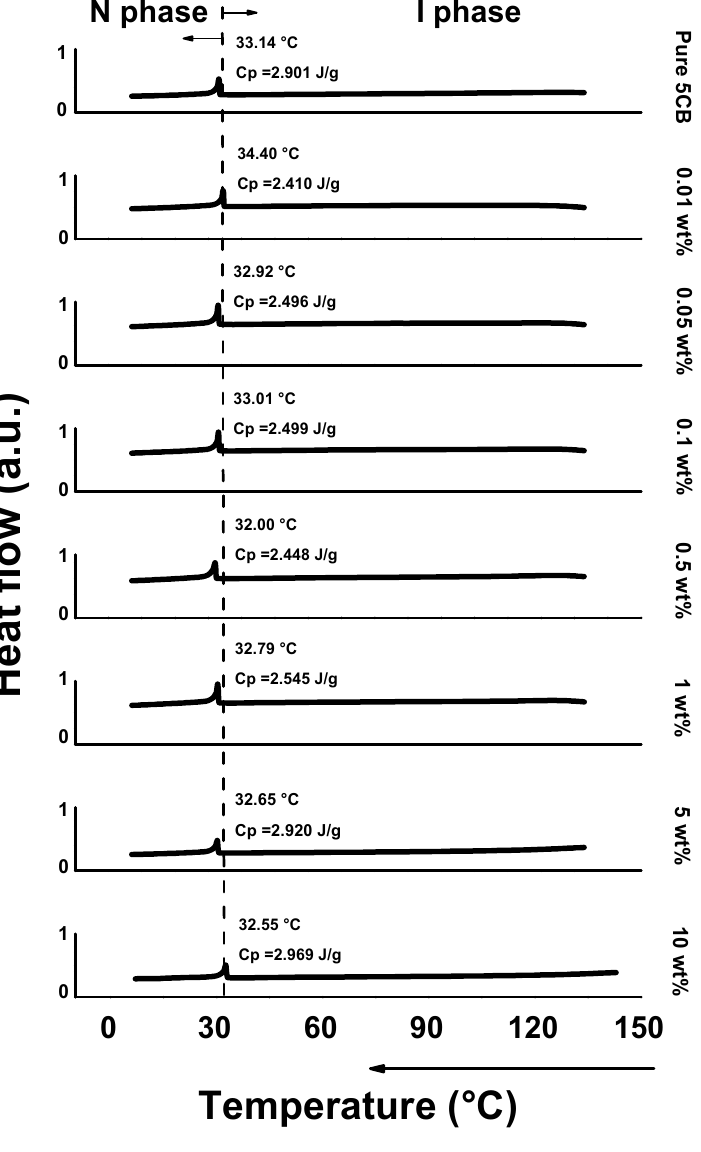
Figure 5. Differential scanning calorimetry (DSC) heat flow results about 5CB+HTAB solutions over a wide temperature range from 0 to 150 ◦ C with 0 ≤ [HTAB] ≤ 10 wt%. Cp: heat capacity. Heat flow was analyzed by cooling the